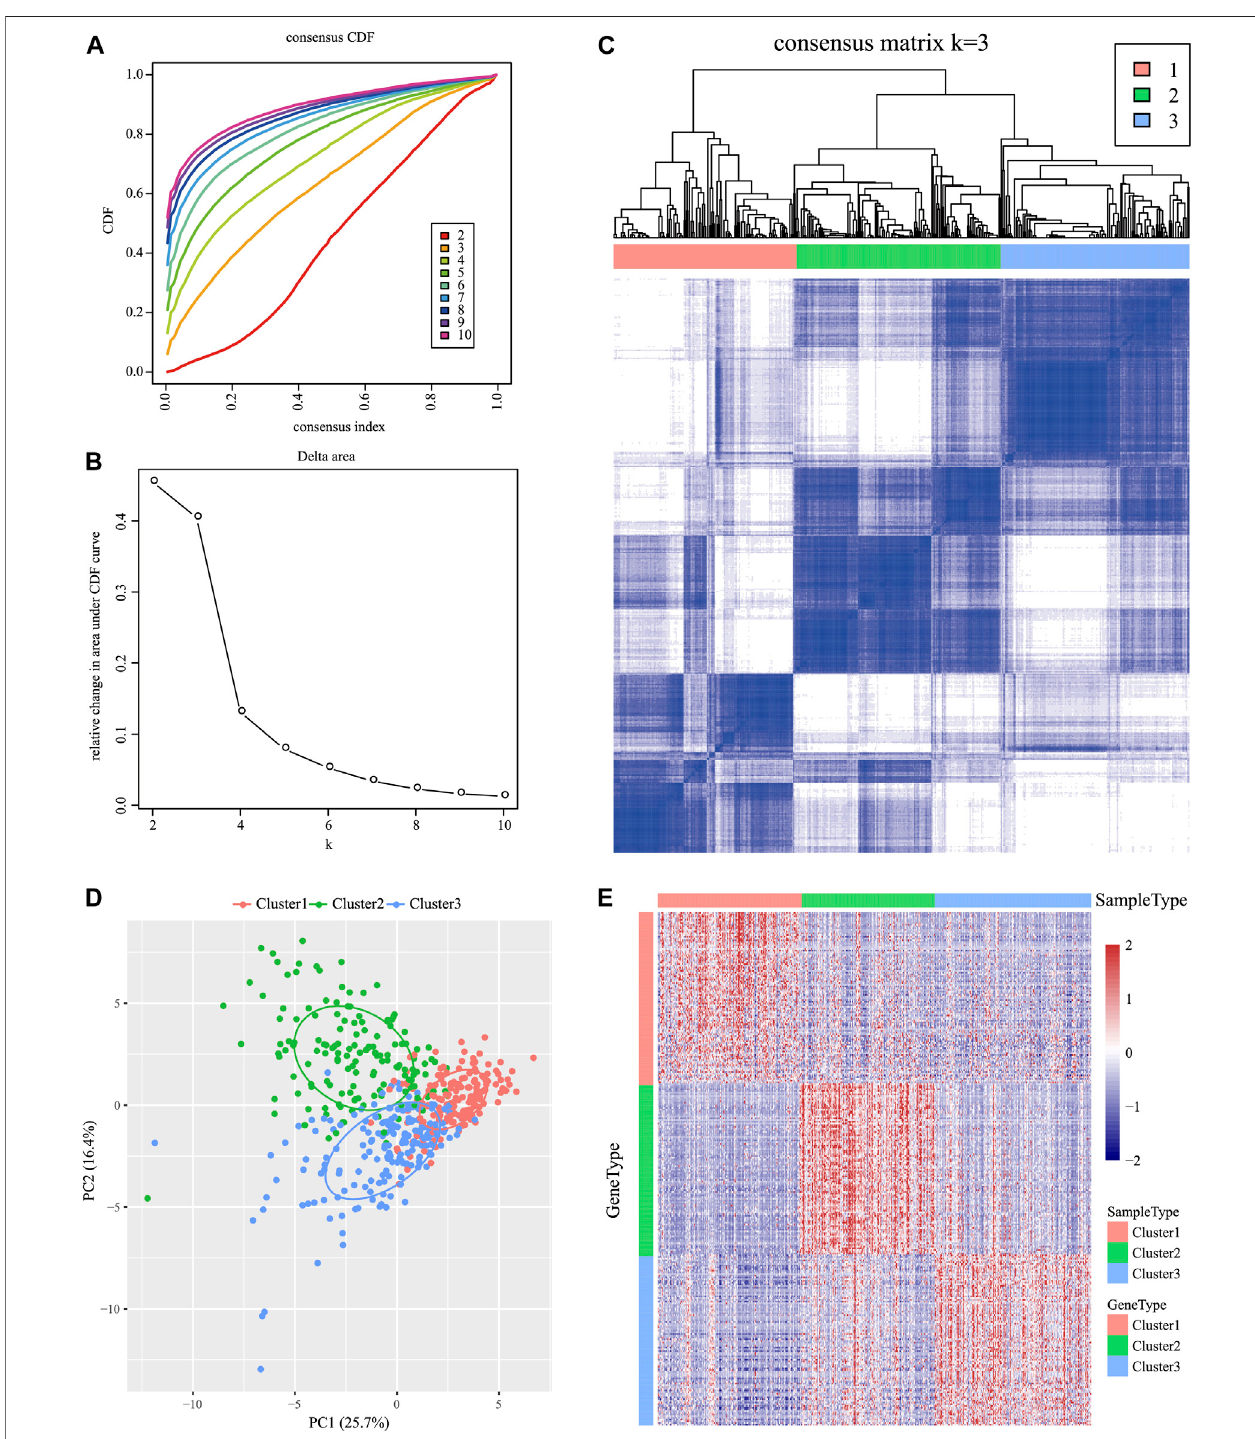
FIGURE 1 | Identi fi cation of immune-associated subtypes of HNSCC in the TCGA cohort. (A) Cumulative distribution function (CDF) curves of consensus scores basedondifferentsubtypenumbers (k=2 – 10)andthecorrespondingcolorsarerepresented. (B) CDFDeltaareacurveofallsampleswhen k=3. (C) Consensusscore matrix of HNSCC samples when k = 3 (1 = C1, 2 = C2, and 3 = C3). (D) Principal component analysis (PCA) ofthe gene expression pro fi le of the upregulated genes. (E) Gene expression heatmap analysis of the top 100 genes that were signi fi cantly upregulated in each subtype.